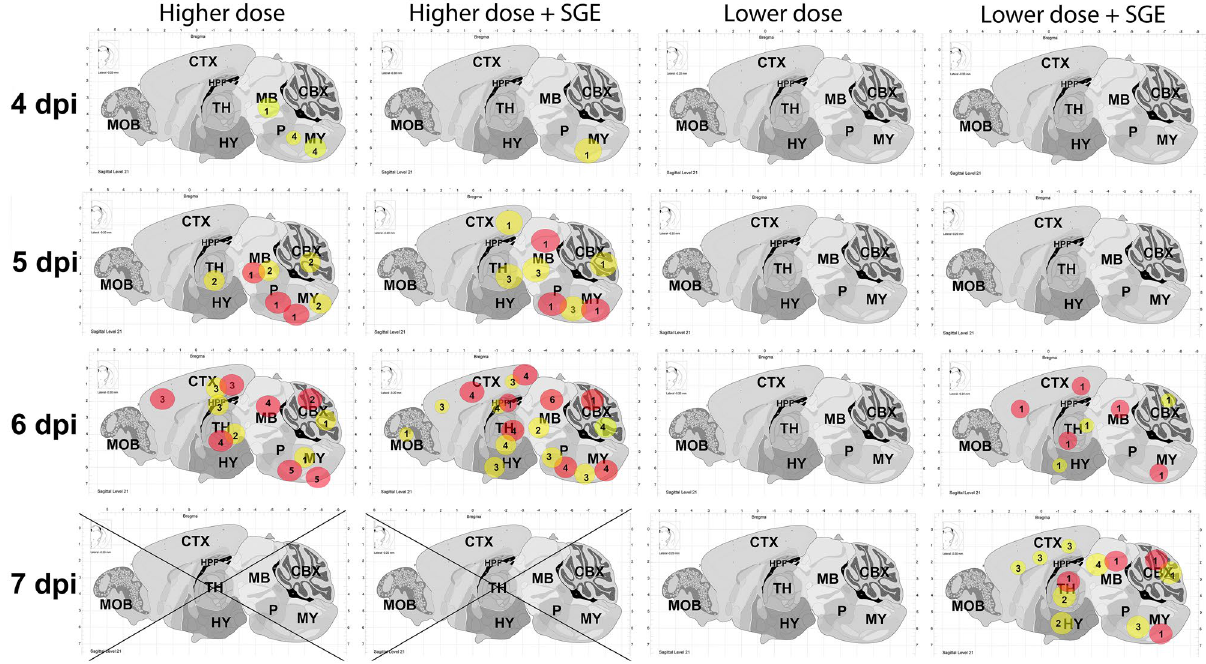
infected with 10 6 PFU of POWV. SGE indicated that 30 μg of Ixodes scapularis salivary gland extract was mixed to the virus before inoculum. Circles indicate POWV-infected regions of the brain. Red circle = highly infected region. Yellow circle = lowly infected region. The number inside each circle represents the number of mice with detectable POWV in a specific region of the brain. “X” represents time points at which all mice succumbed to disease. MY medulla, P pons, MB midbrain, CBX cerebellum, TH thalamus, HY hypothalamus,